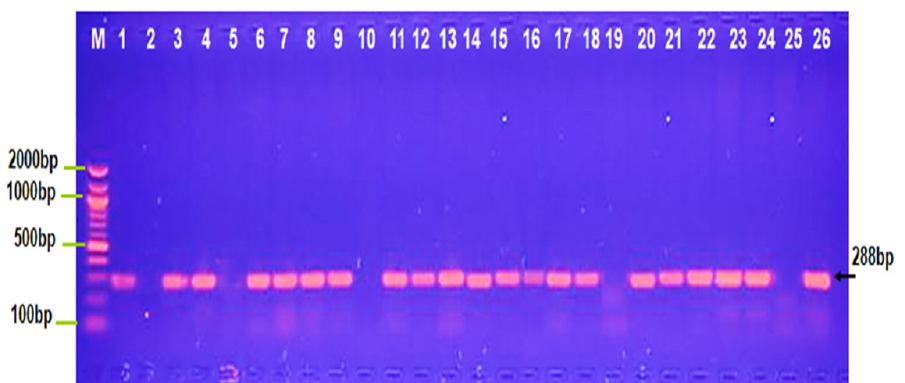
Fig. 1. Agarose gel electrophoresis image that shown the PCR product of a virulence factor gene ( traT ) at (258bp) in different bacterial isolates. Where M: Marker (2000-100bp), lane (1-5) E . coli , lane (6-10) K . pneumonia , lane (11-15) Salmonella typhi , lane (16-20) Shigella dysentery , lane (21-22) Serratia marcescens and lane (23-26) Proteus vulgaris